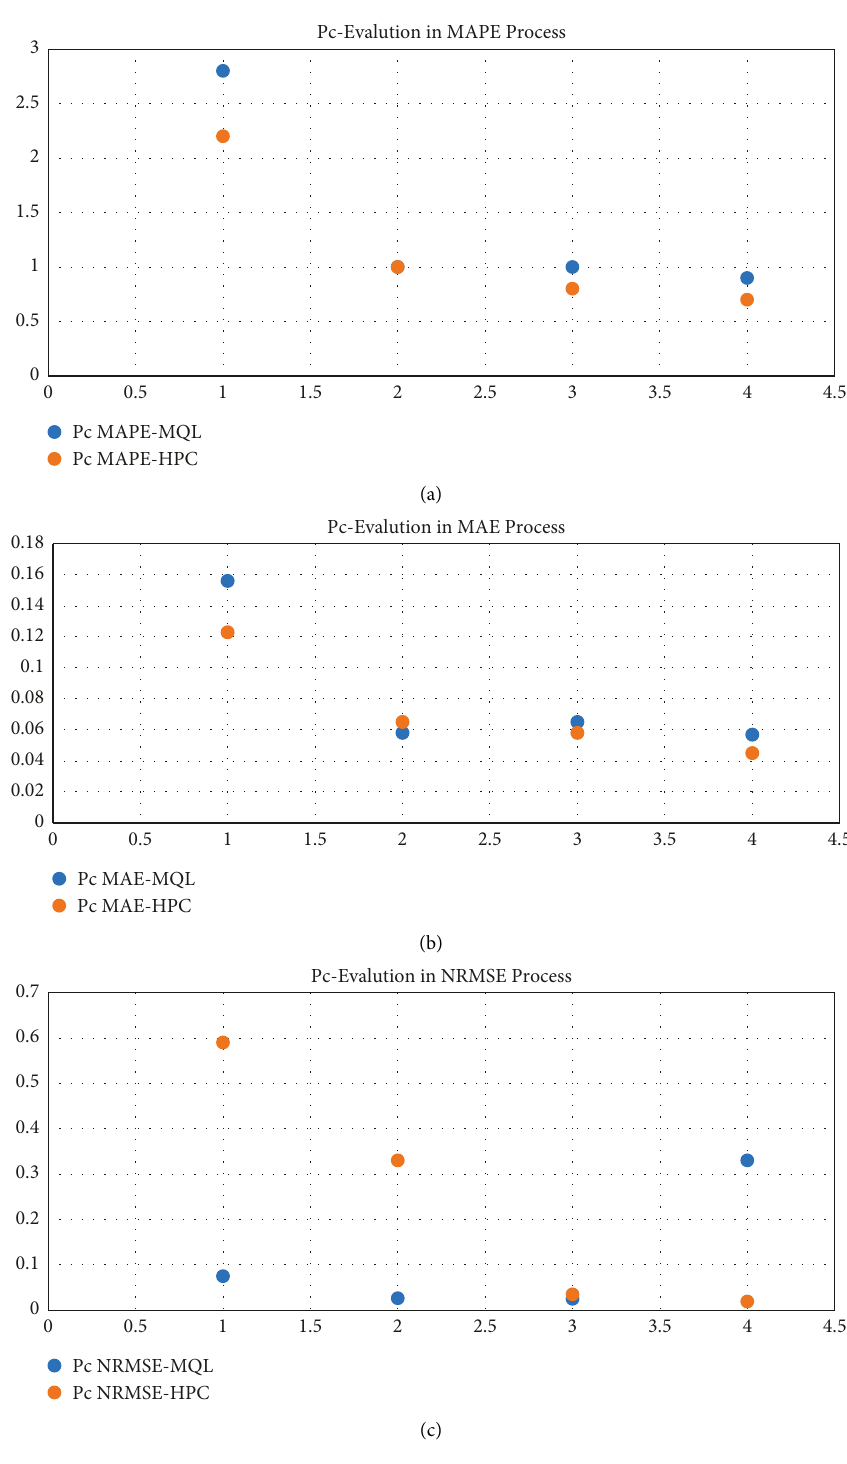
Figure 5: (a–c) Machine learning performance for reducing cutting power. (a) Pc-evaluation in MAPE models. (b) Pc-evaluation in MAE process. (c) Pc-evaluation in NRMSE